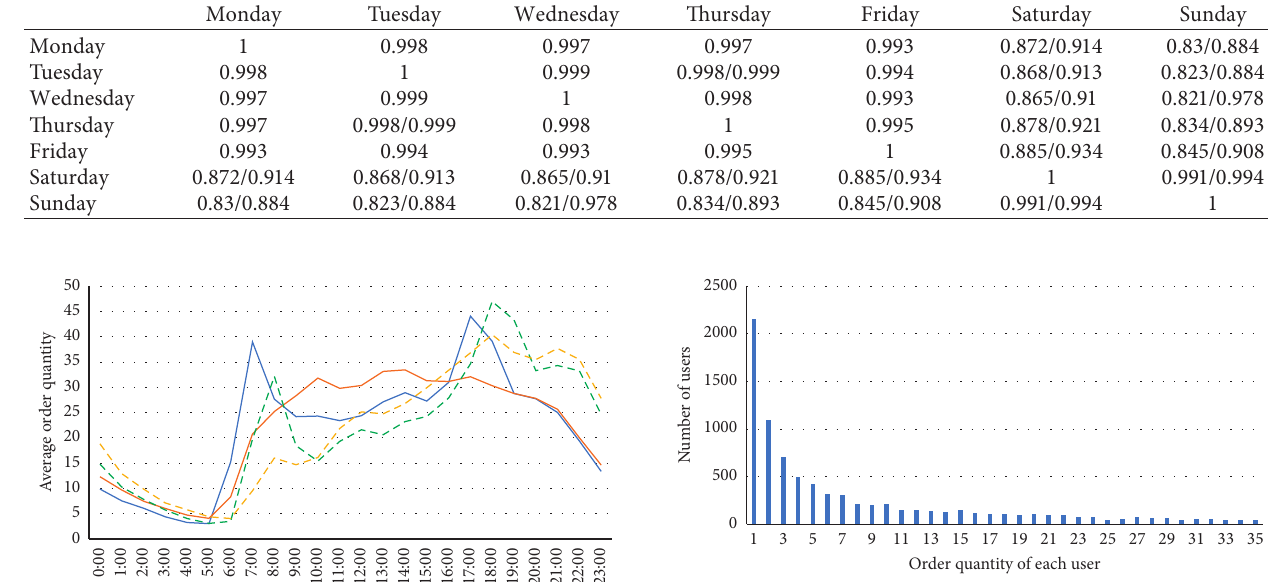
Figure 5: Frequency distribution of users based on the number of orders of each user.